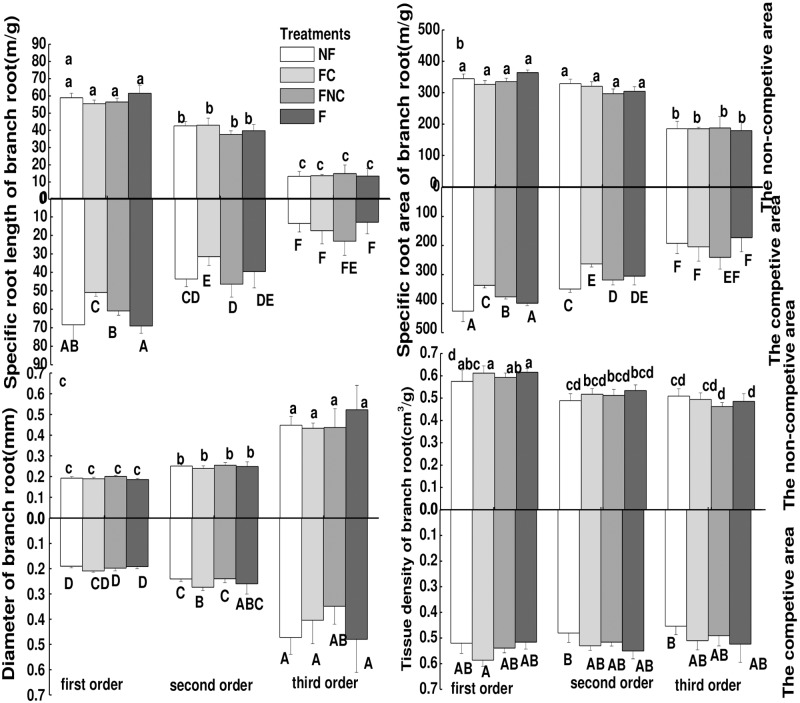
Fine root morphology (SRL (a), SRA (b), Diameter (c), Tissue density (d)) at different branch order affected by the competition and its interaction with nutrients heterogeneity in the competitive and non-competitive compartments.Different lowercase letters (eg. a, b, c) indicate significant treatment effect between the means in the non-competitive and the capital letters (eg. A, B, C) indicate significant treatment effect between the means in the competitive compartment at p<0.05 analyzed by post hoc Tukey’s HSD test (means ± SE, n = 8).